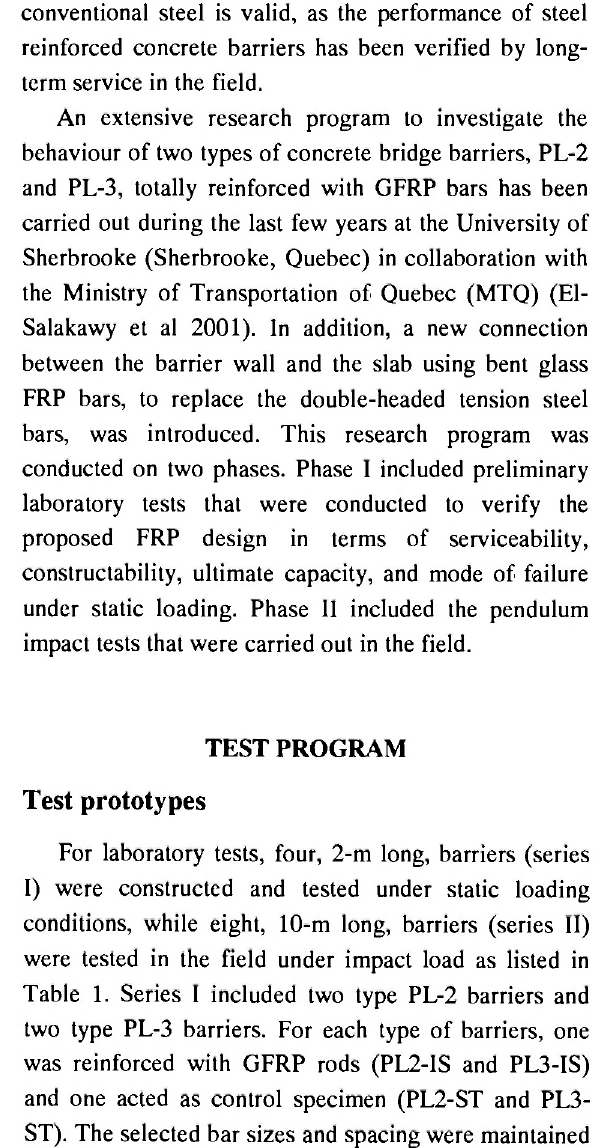
reinforcing bars have four different shapes with the wall to the slab using GFRP bent bars. Three